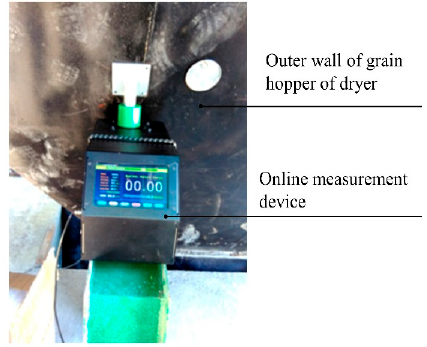
Figure 15. Experimental apparatus for verifying the accuracy of the device in field tests.